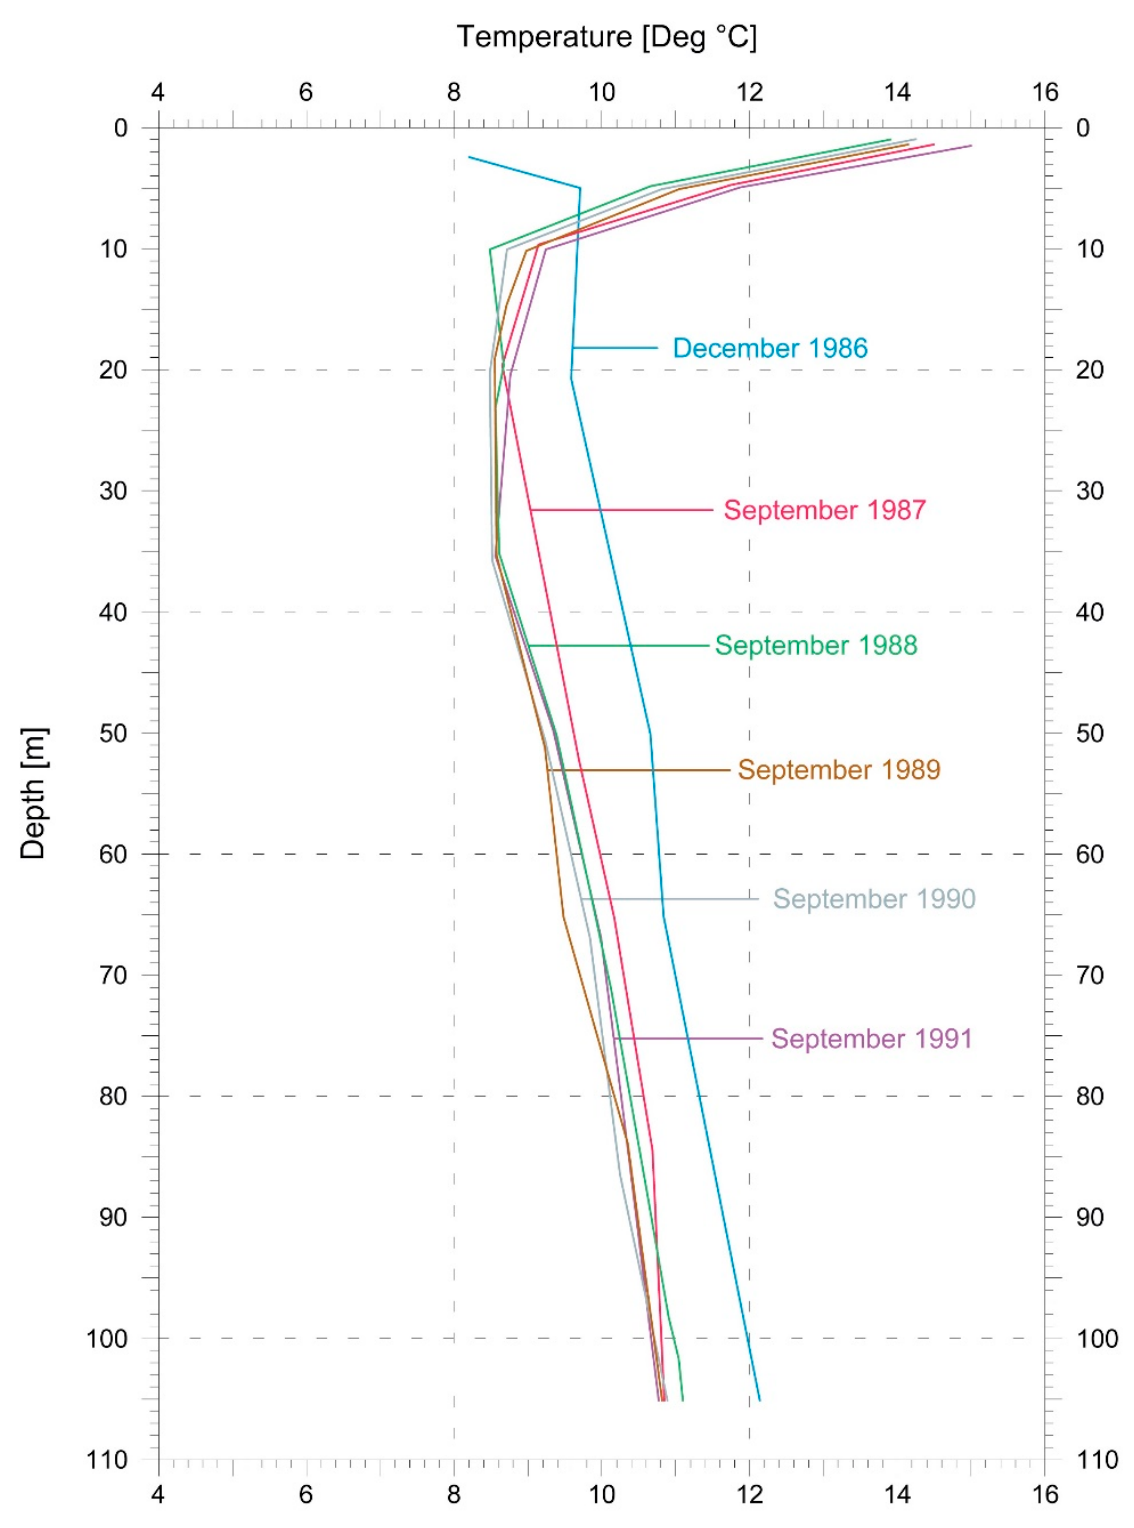
Figure 4. Temperature profiles measured in 0.5 m distance from the BHE in Elgg during the first data acquisition campaign. The December 1986 curve marks the undisturbed profile at the start of the first heating season. The following curves show the temperatures after winter heat extraction and summer recovery, just before the start of the next heating season. The data in the top 10 m reflect the seasonal changes. Data from [7] are plotted.